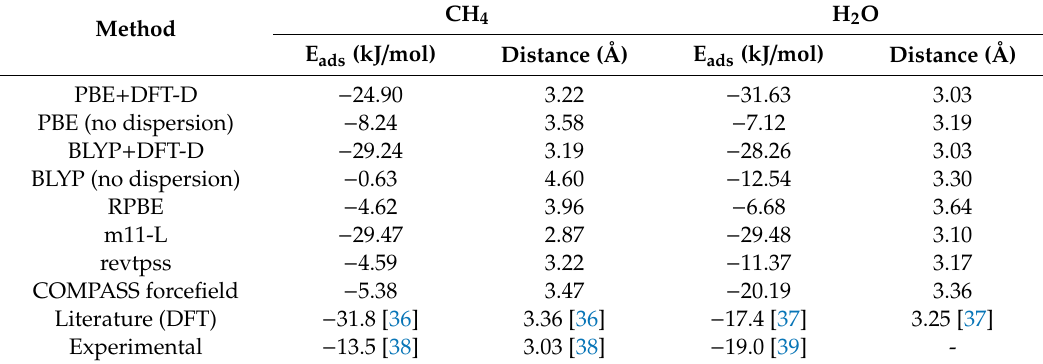
Table 1. Binding energies and distances of CH 4 and H 2 O on the graphene predicted by di ff erent DFT functionals and the COMPASS forcefield. For Perdew–Burke–Ernzerhof (PBE) and BLYP functionals, we also tested the e ff ect if no dispersion corrections are considered. Binding energy E ads is defined as E ads = E (surface + adsorbate) − E(surface) − E(adsorbate). A more negative E ads value means stronger binding. For comparison, values from previous theoretical and experimental studies are also included. RPBE = revised